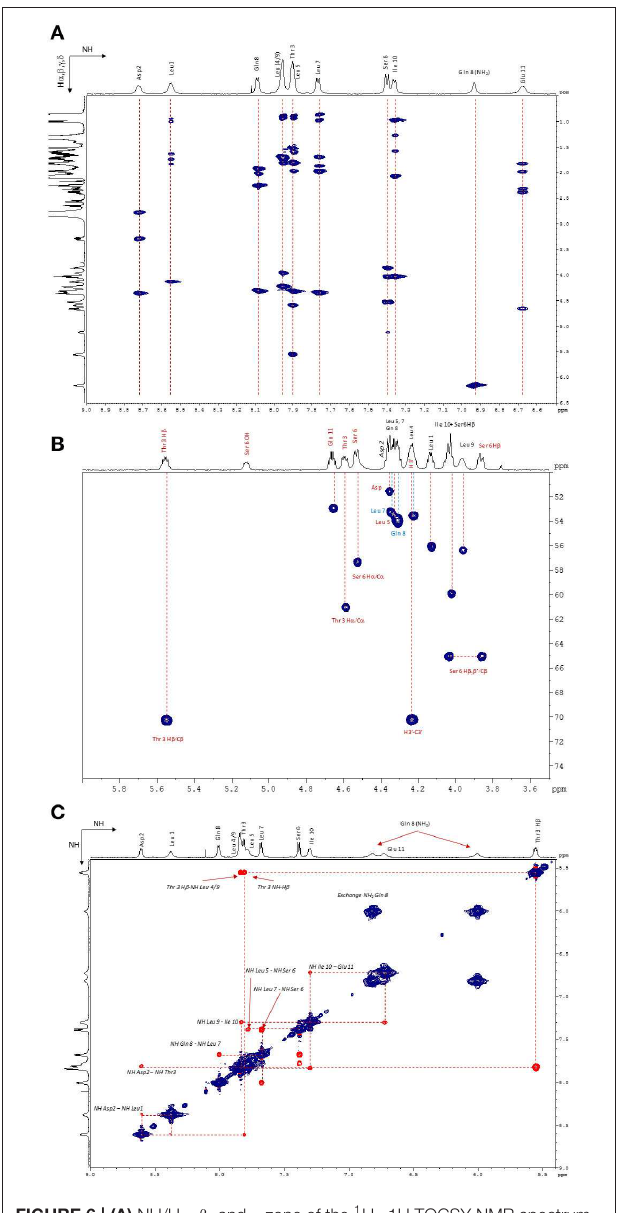
FIGURE 6 | (A) NH/H α , β , and γ zone of the 1 H − 1H TOCSY NMR spectrum (600 MHz, 298K, Acetone-d 6 ). (B) H α /C α zone of the 1 H– 13 C HSQC NMR spectrum (600 MHz, 298K, Acetone-d 6 ). (C) NH/NH zone of the 1 H– 1 H NOESY NMR spectrum (600 MHz, 323K, Acetone-d6).